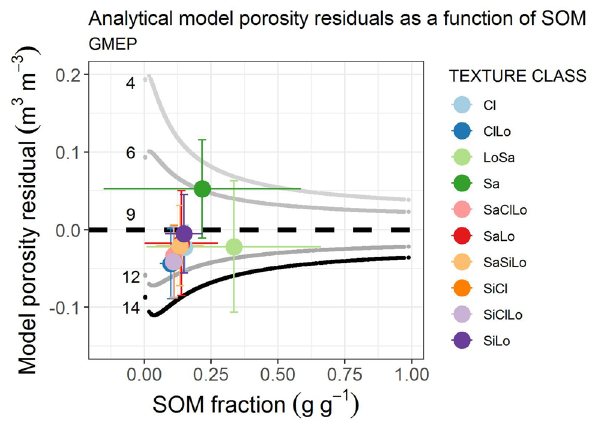
Figure 6. Residuals plotted as a function of SOM for the respective soil texture groups. Markers are color coded by texture class: clay (Cl), clay loam (ClLo), loamy sand (LoSa), sand (Sa), sandy clay loam (SaClLo), sandy loam (SaLo), sandy silty loam (SaSiLo), silty clay (SiCl), silty clay loam (SiClLo), silty loam (SiLo). Median CN values for each texture class shown in Supplementary Table S1. The residuals show a clear particle size effect in the expected direction. The coarse sandy soils having the lowest coordination number and the fine grained clay soils with a broad particle size distribution having the highest CN. This indicates that CN contains both the shape effect and the secondary particle size